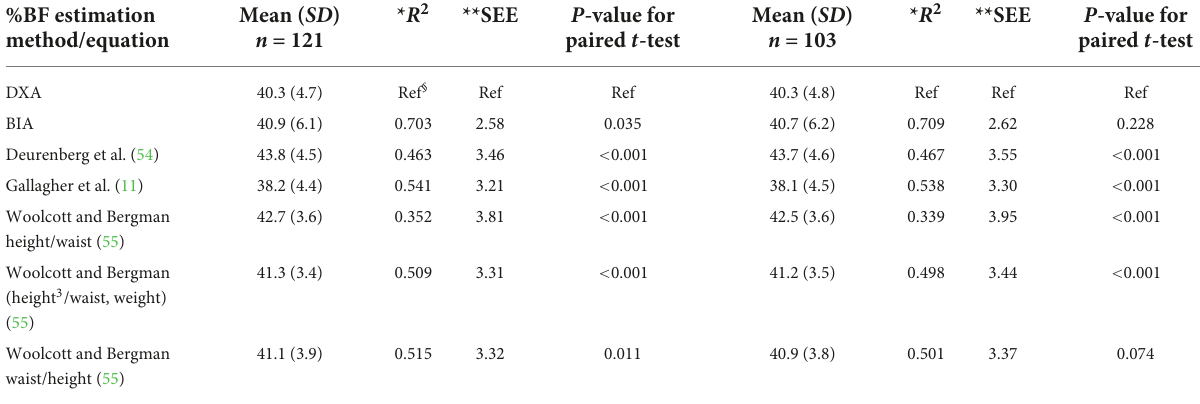
TABLE 3 Mean percentage body fat (%BF) estimated by DXA, BIA and equations using anthropometric characteristics for the entire group ( n = 121) and a subgroup of women with heights greater than 145 cm ( n = 103) and the results of regression models and paired t- test. %BF estimation method/equation